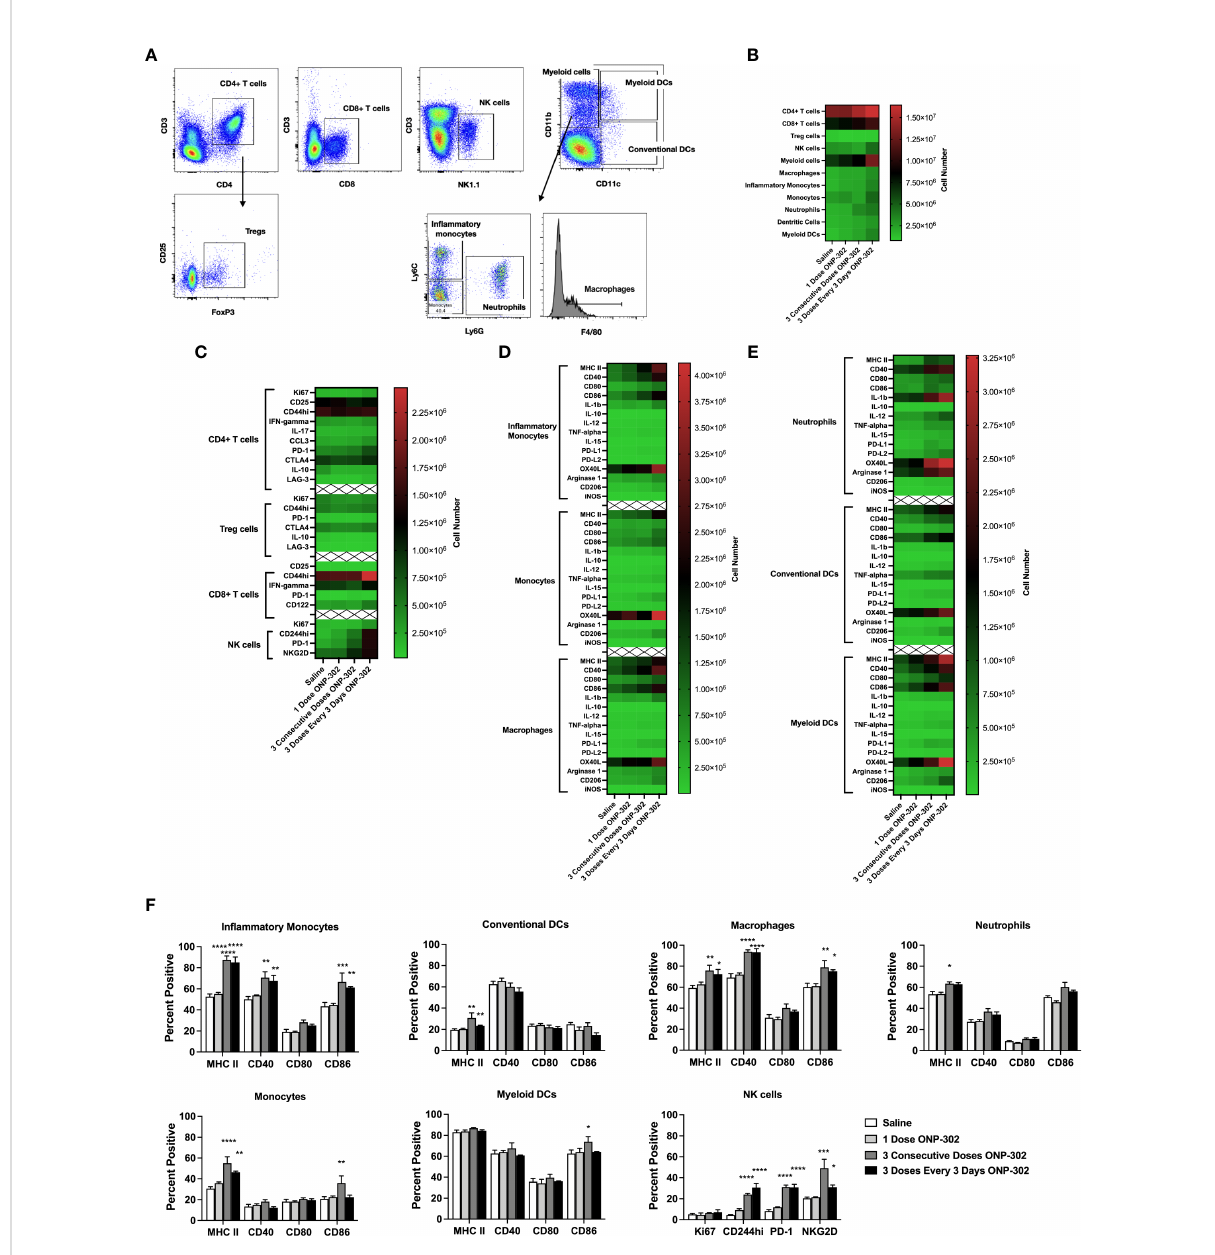
FIGURE 2 ONP-302 treatment increases the number and frequency of activated immune cells. Naïve female C57BL/6 mice (n = 3 per group) were treated similarly to Figure 1. Twenty-four hours after the last injection, spleens were collected to assess the immune cell populations present. A gating schematic detailing how cells were identi fi ed is shown (A) . The total number of cells (B) , as well as the phenotypes of CD4 + T cells, CD8 + T cells, NK cells (C) , monocytes and macrophages (D) , as well as other myeloid cells (E) are shown as heatmaps. The frequency of speci fi c populations expressing cellular markers of activation after treatment is shown in (F) The data are presented as the mean percentage of cells +/- S.E.M. One representative experiment of two is presented. Asterisks (*, **, ***, ****) indicate a statistically signi fi cant difference as compared to saline treated mice, p < 0.05, < 0.01, < 0.001, and < 0.0001